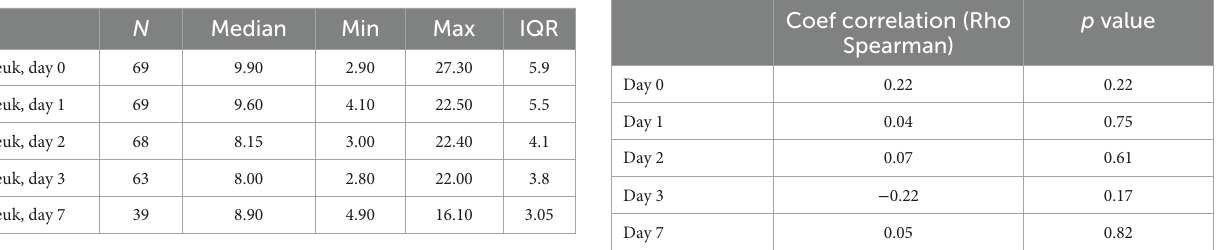
TABLE 9 Correlation of H-FABP with leukocytes. TABLE 5 Levels of leukocytes in days 0–7 within the study cohort (mg/L).